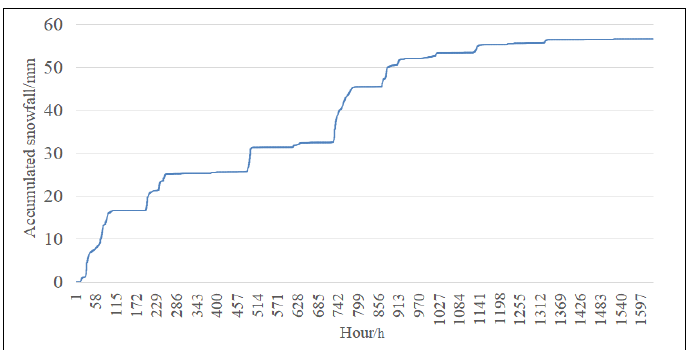
Figure 13. Chart of hourly accumulated snowfall at Jiagedaqi meteorological station from October to December 2020. Source: (https://www.xihe-energy.com/, accessed on 9 March 2022). December 2020. Source: (https://www.xihe-energy.com/, accessed on 9 March